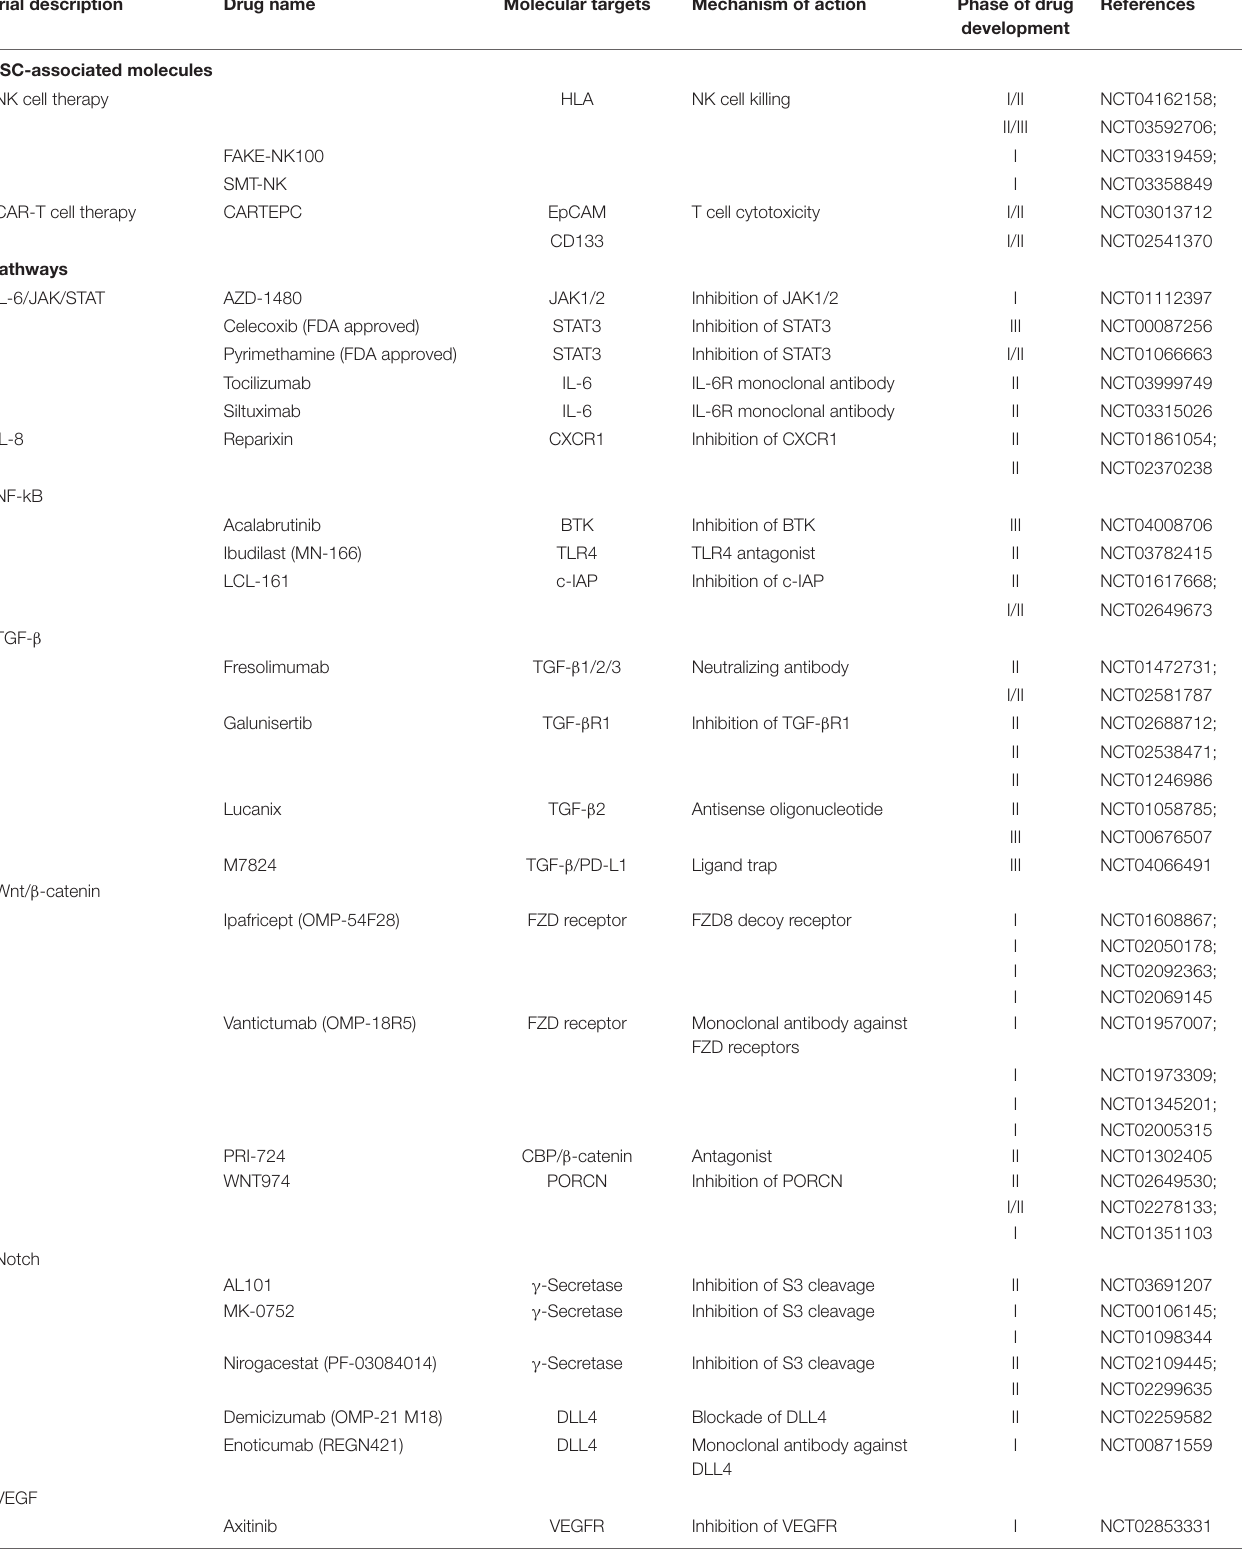
TABLE 1 | Therapeutic strategies targeting the CSC niche and their development